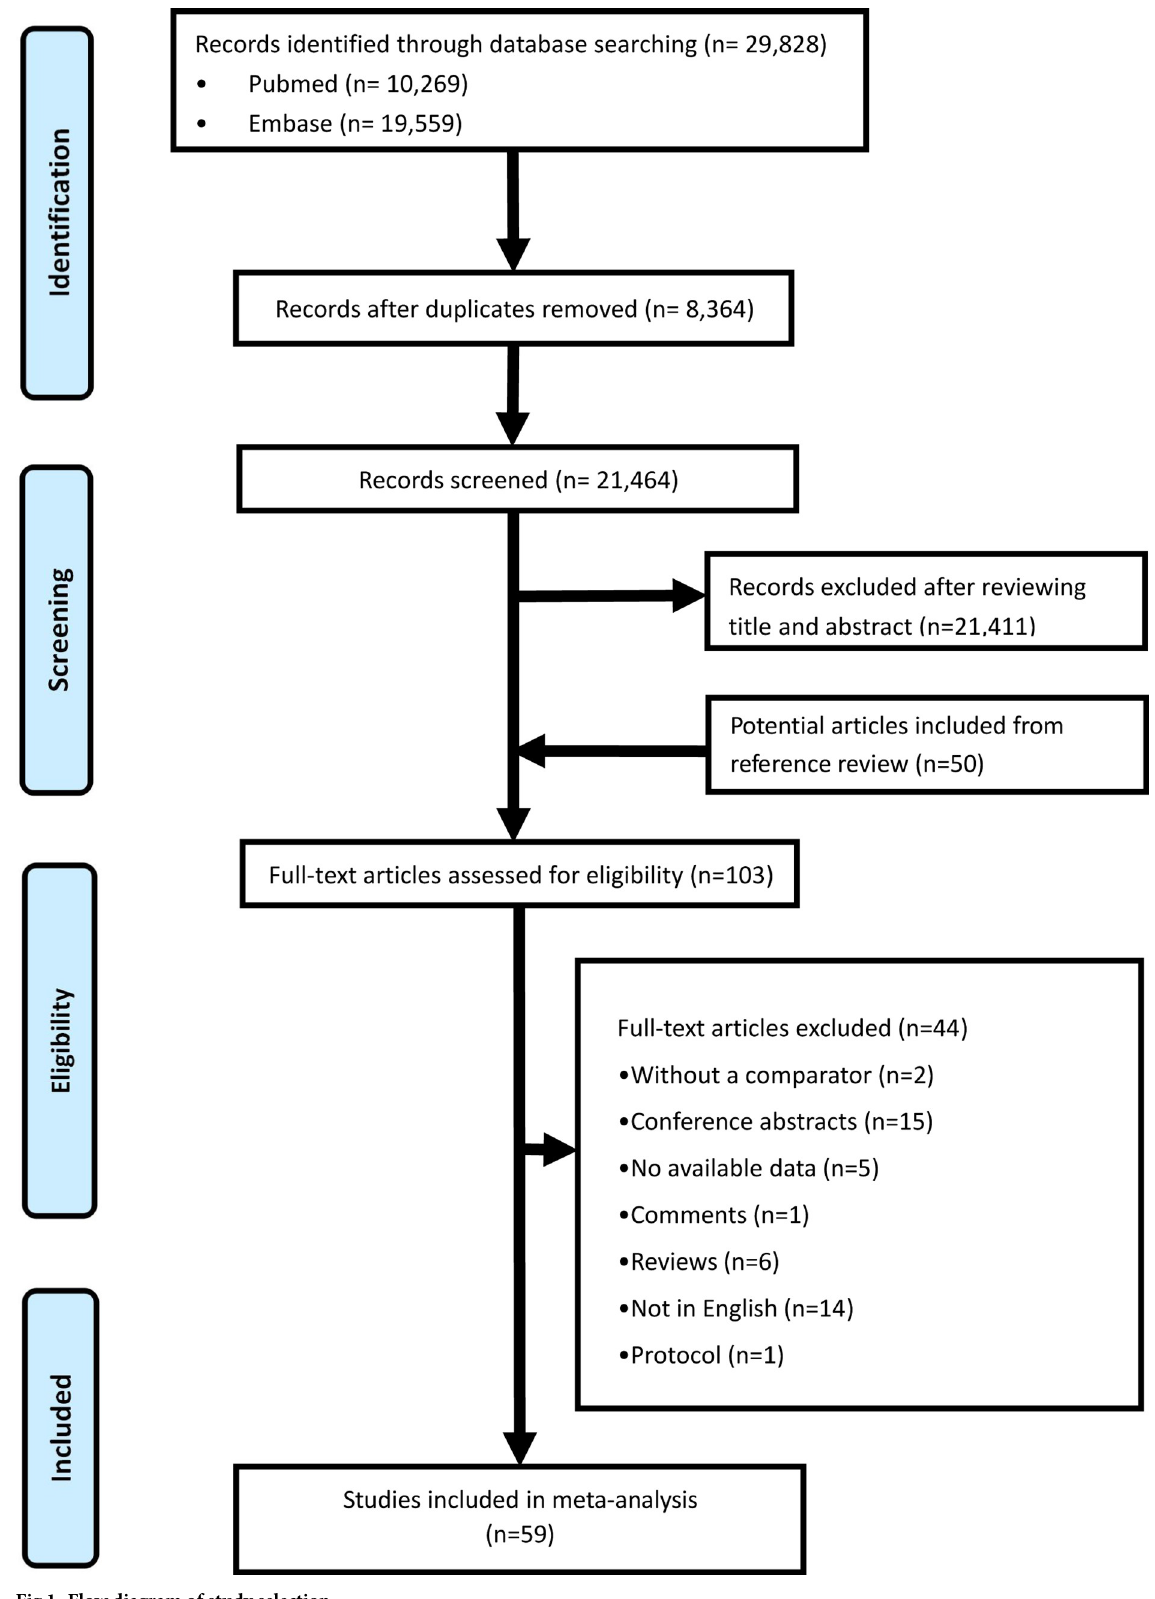
Fig 1. Flow diagram of study